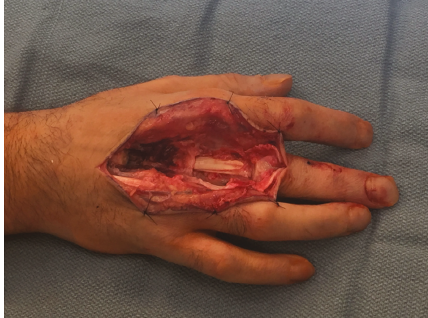
Figure 6: Gross surgical image of dead space after ray resection/tumor excision.